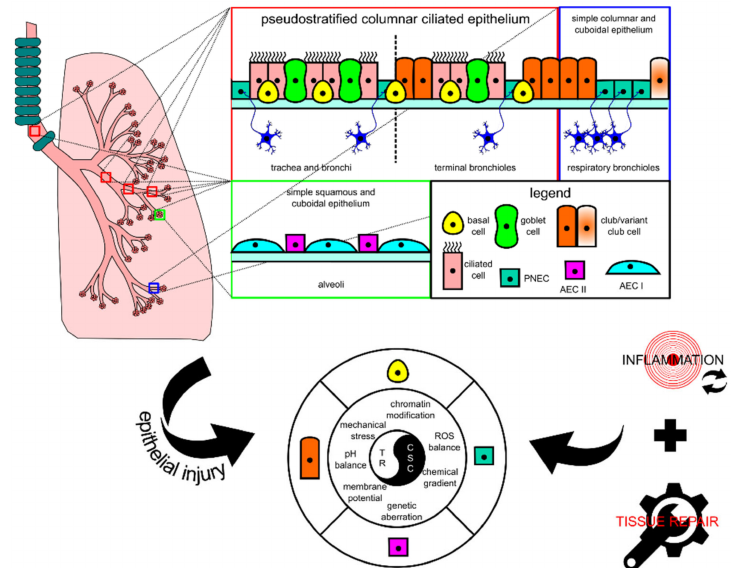
Figure 1. Schematic diagram showing the histological and cytological variations in different locations of the lung. In each tissue, there is at least one type of progenitor cell that is capable of proliferation, facilitating tissue repair in case of injury. In lung injury-triggered carcinogenesis, repeatedly induced inflammation accompanied by tissue repair could potentially lead to a chronic state that changes various extracellular and intracellular modulators and consequently encourages the emergence of lung cancer stem cells (CSCs) from progenitor cells. CSCs and tissue resolution (TR) are two sides of the same coin. AEC, alveolar epithelial cell; PNEC, pulmonary neuroendocrine cell; ROS, reactive oxygen